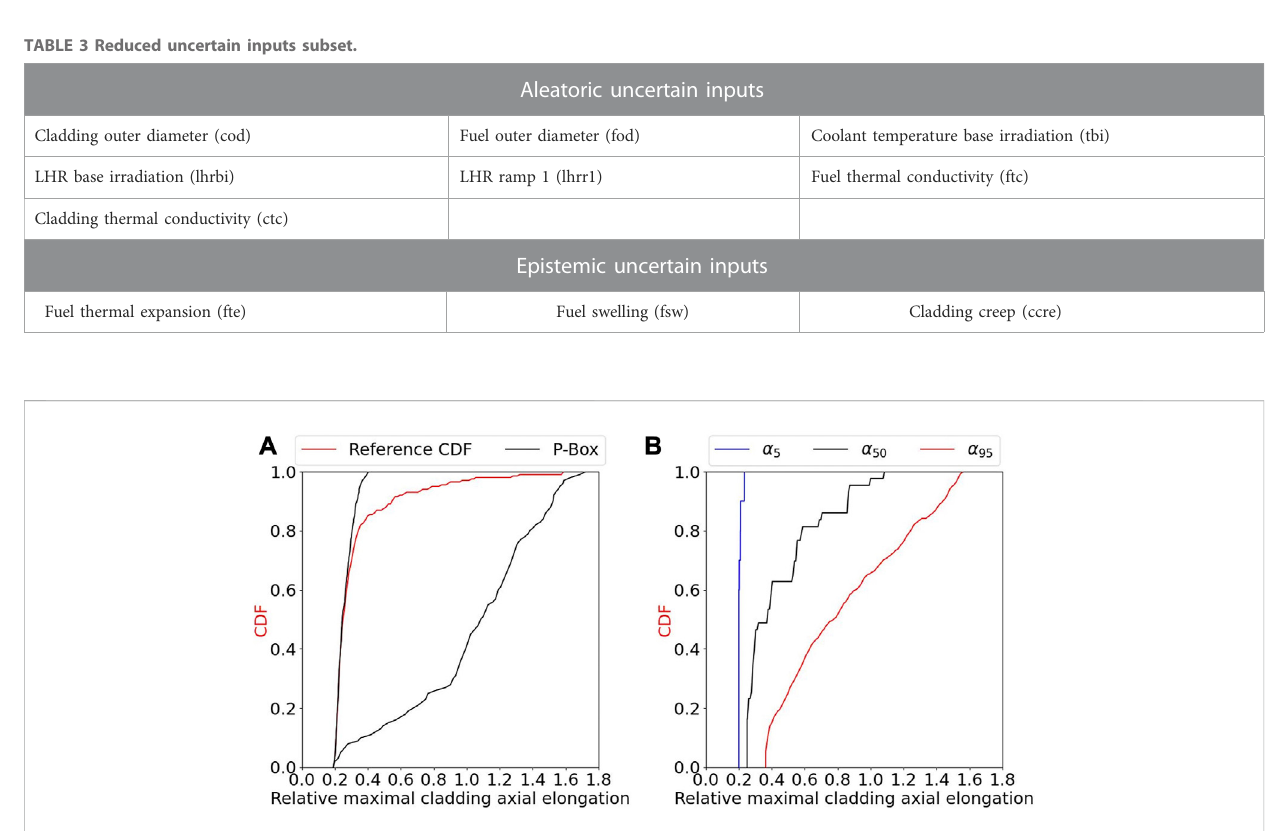
FIGURE 6 Maximal cladding elongation during the cold ramp 1 (A) P-box and reference CDF (B) 5 th , 50 th , and 95 th percentile